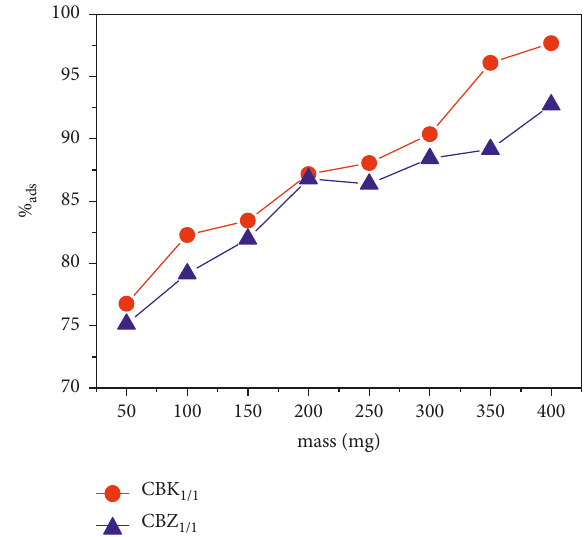
Figure 9: Effect of adsorbent dosage on the adsorption of indigo carmine. Experimental conditions: C 0 � 50mg · L − 1 ; V � 20 mL; pH � 2; t � 80 min; speed � 200rpm at room temperature.